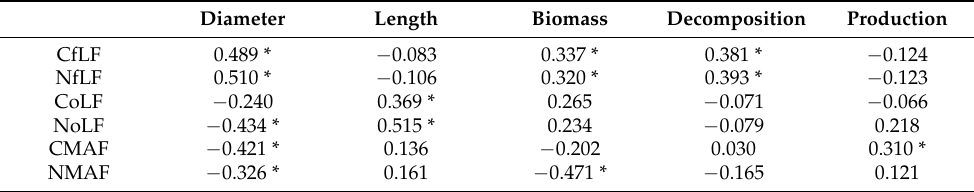
Table 4. Correlation between soil organic matter fractions and root characteristics.